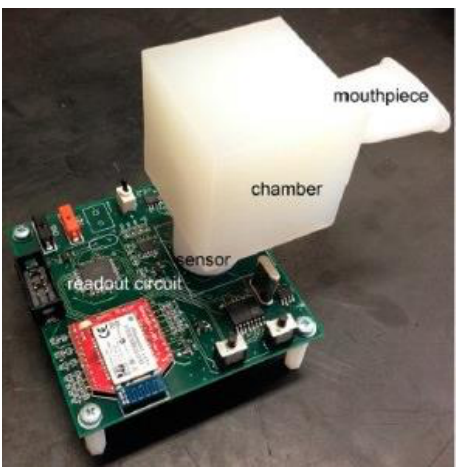
Figure 4. Novel Isoprene Sensor readout with Bluetooth mode. Reproduced with permission from Gouma et al., Sensors; published by MPDI, 2017.